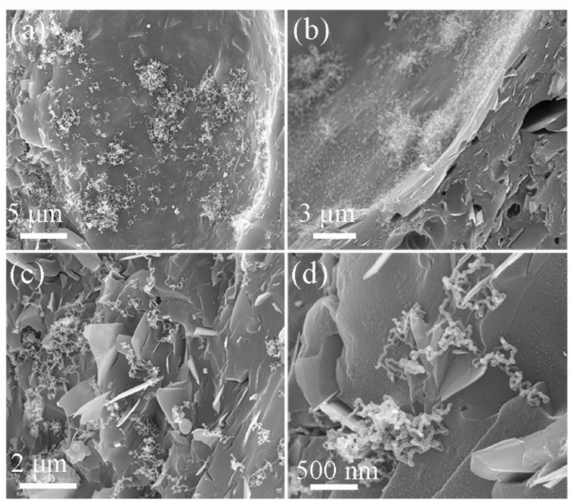
Figure 9. SEM images of samples with 5 wt.% GNP / PF with 1 wt.% Ni(NO 3 ) 2 · 6H 2 O pyrolyzed at 1000 ◦ C in di ff erent regions. ( a , b ) Shows short-column carbon materials grew in bunches, ( c , d ) shows the exfoliated GNPs uniformly distributed in the curved, fibrous and nano-sized carbon materials.